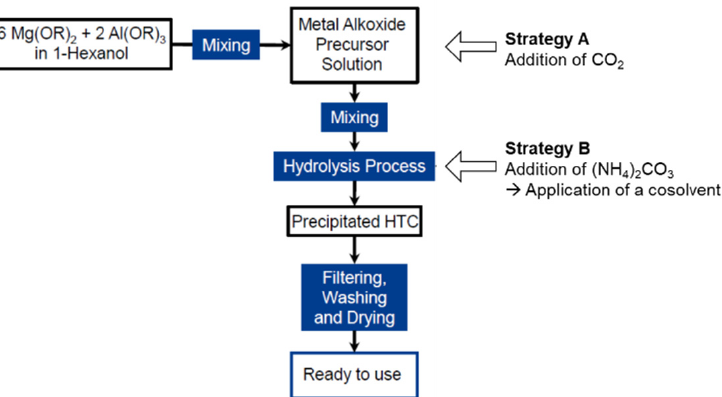
Figure 5. Schematic representation of the synthesis of LDHs from alkoxides via an alcohol exchange reaction and subsequent hydrolysis. As carbonate sources, either CO 2 (Strategy A) or (NH 4 ) 2 CO 3 (Strategy B) can be utilized. (R: alkyl rest).